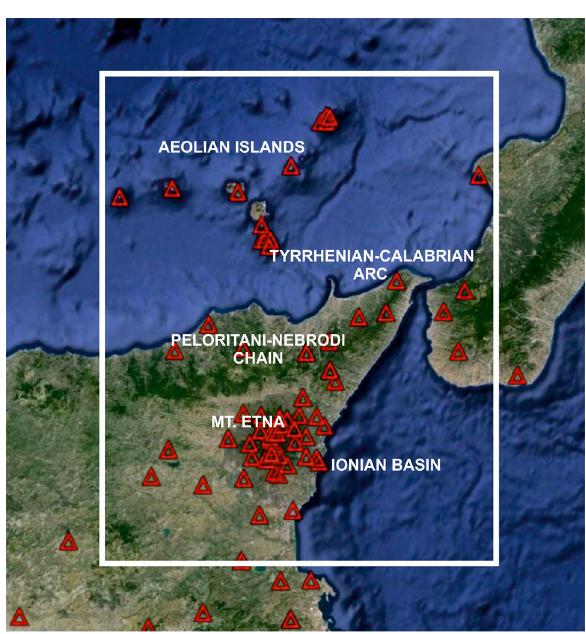
Figure 7. Map of the location of the seismic stations of the INGV permanent network, Italy, used in the TOMO-ETNA